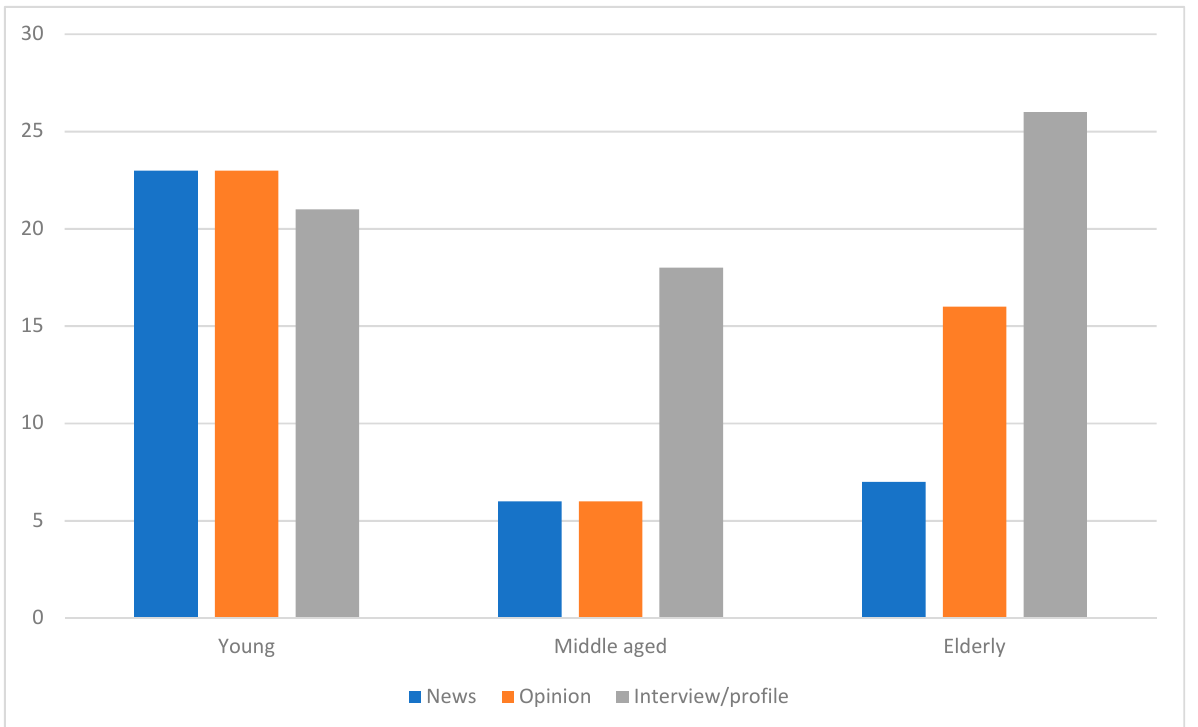
Figure 1. Young, middle aged and elderly by genre.